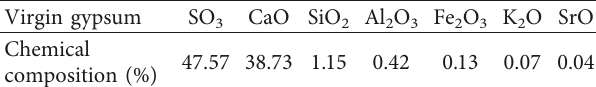
Table 1: Chemical composition of VG